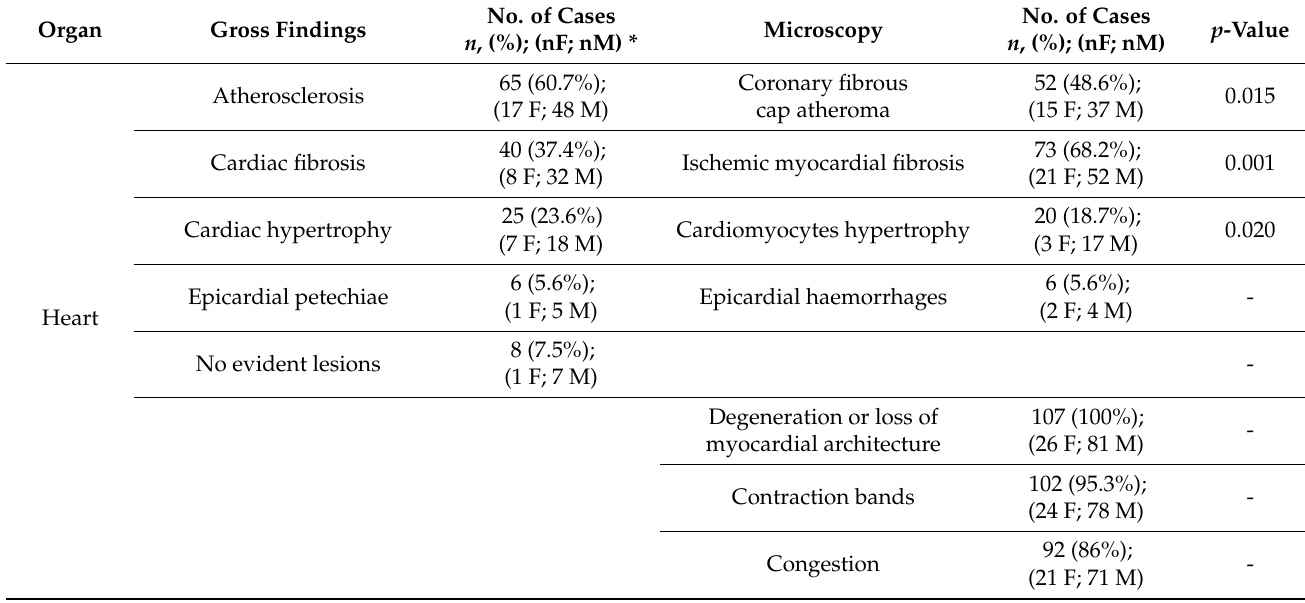
Table 3. The gross and microscopic features of the heart and kidneys in our study